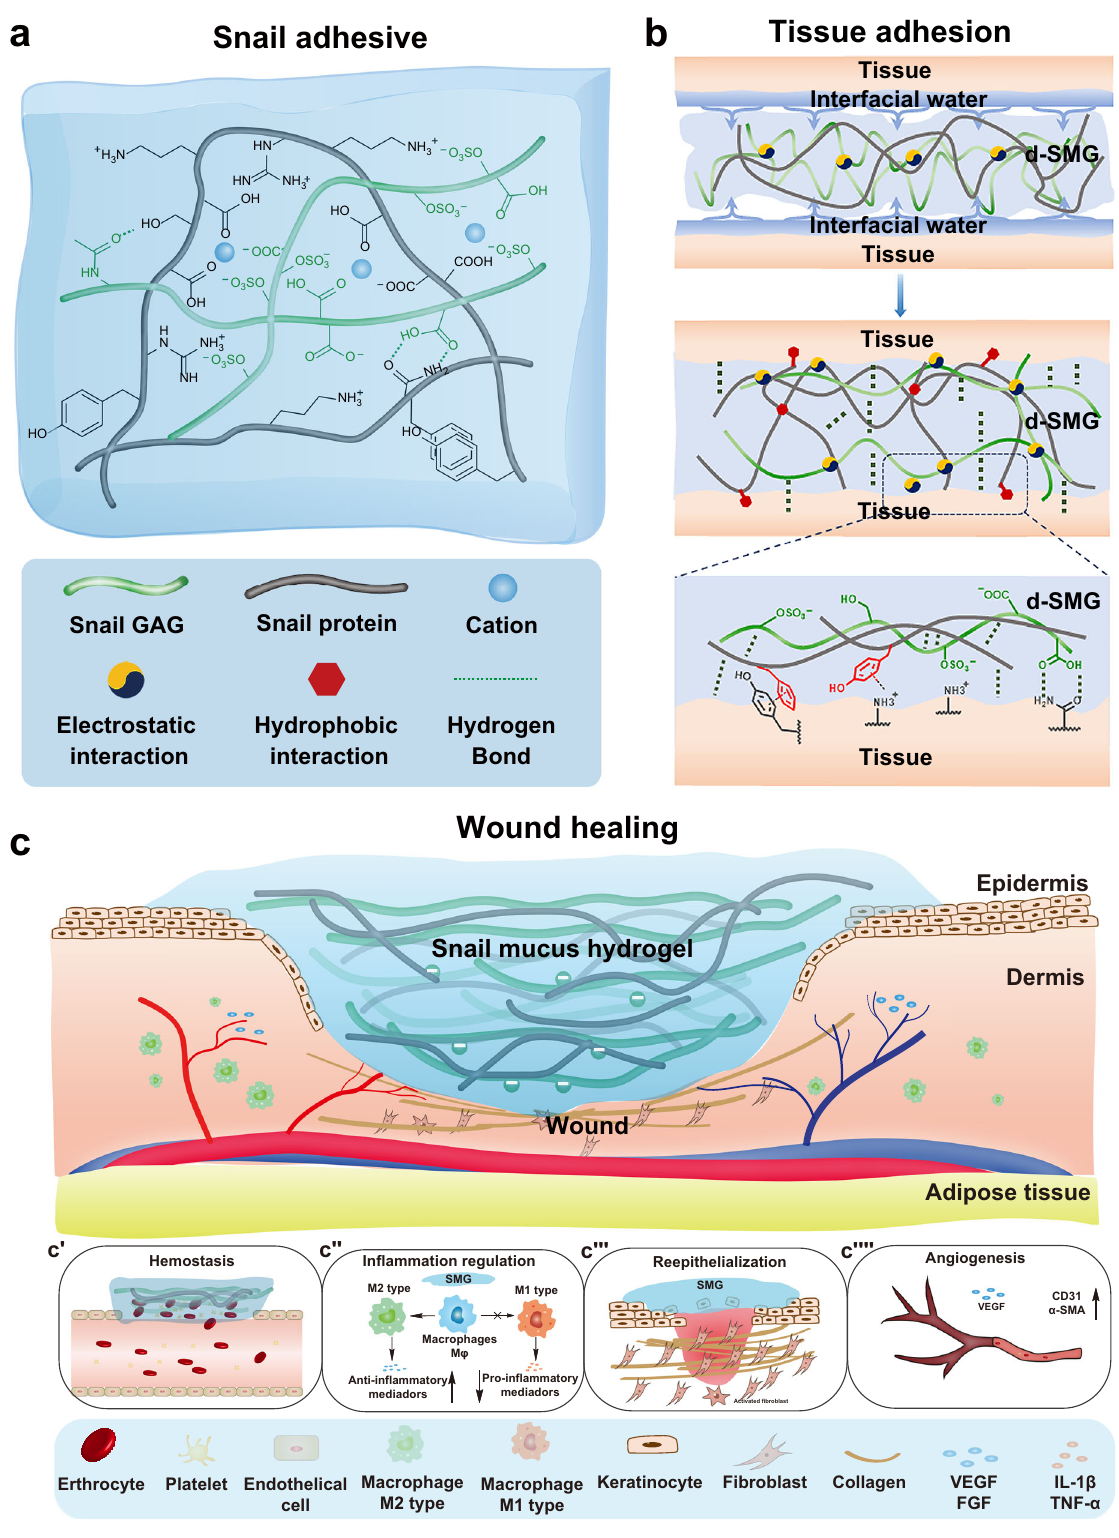
Fig. 9 | Schematic interpretation of the mechanism d-SMG in wound healing. a Formationof double-networksnail-mucushydrogel. b Apossibletissueadhesion mechanism of d-SMG. c The postulated mechanism of d-SMG in accelerating